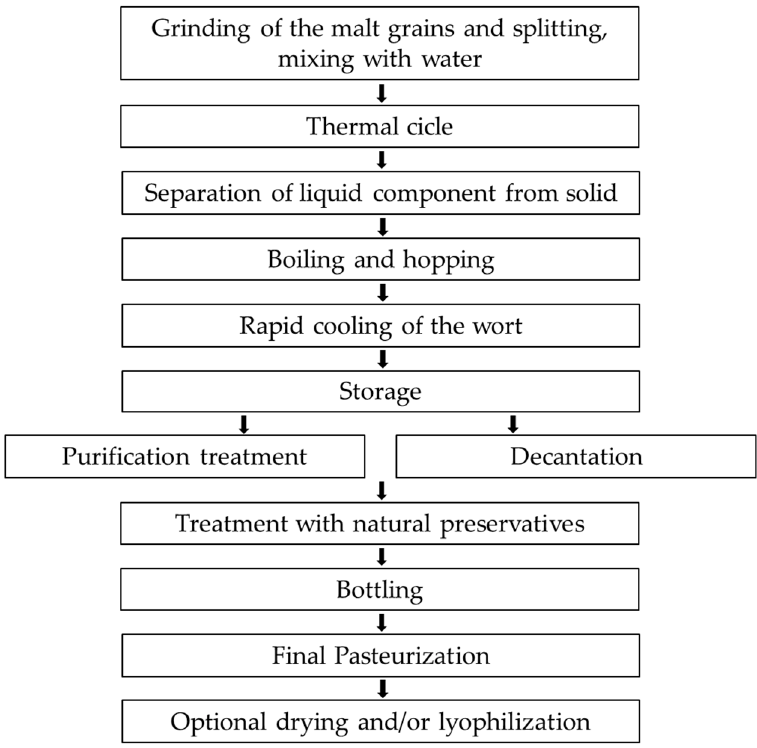
Figure 1. The block diagram shows the key step in the production of Aliophen ® (see text for de- scription).